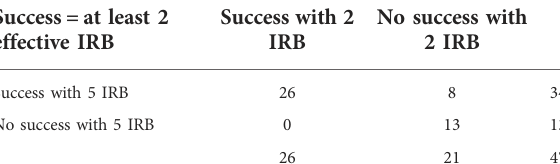
TABLE 1 Cross-classi fi cation of the number of duos that performed at least two correct ventilations (considering 20 – 60 ml target volumes) within the fi ve IRB and alternatively only considering the fi rst two of these fi ve IRB. Success = at least 2 effective